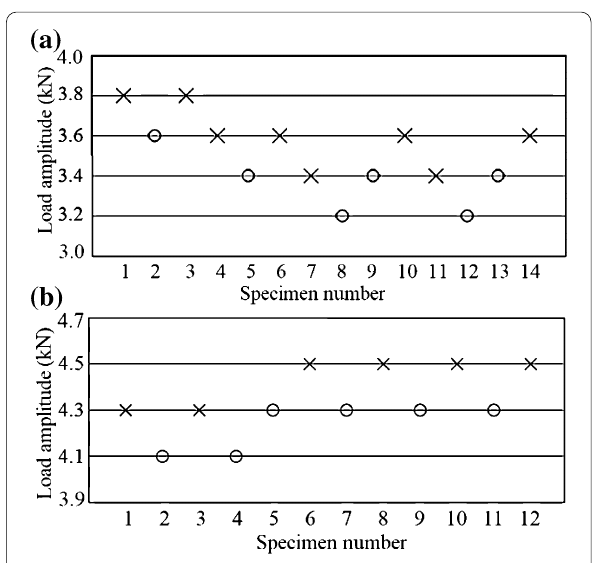
1.5-N, b 1.5 0.8-P specimens + +